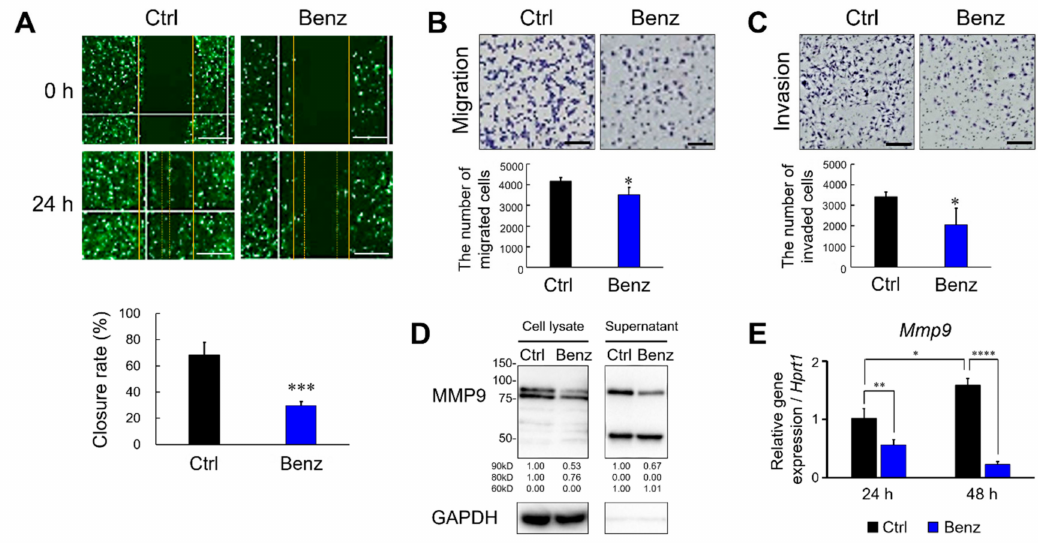
Figure 3. Suppressive actions of Benztropine on the migration and invasion of cancer cells. ( A ) Wound healing assay. The solid lines indicate the initial wounds. The dotted lines indicate the leading edge of the closing wound. Upper panel, representative images. Lower panel, rate of the wound closure. Mean ± SD, n = 4. *** P < 0.001 vs Ctrl. ( B , C ) Migration and invasion assays using a transwell system. LuM1 cells were treated with Benz (50 µ M) for 24 h. The ( B ) migrated and ( C ) invaded cells were stained with Di ff -Quick and then counted. Upper panels, ( B ) representative images of the migrated cells and ( C ) invaded cells. Scale bars, 100 µ m. Lower panels, the number of cells migrated or invaded in a well. Mean ± SD, n = 3. * P < 0.05 vs Ctrl. ( D ) Western blot showing MMP9 altered by Benz treatment. LuM1 cells were treated with Benz at 50 µ M for 24 h. Whole cell lysate and culture supernatant were prepared from the cells cultured in a serum-free medium for 24 h. Bands of approximately 90 kD (pro-form), 80 kD (active-form), and 60 kD (short-form) of MMP9 were detected. GAPDH, loading control. Densitometric readings for all western blots were calculated relative to the Ctrl. ( E ) RT-qPCR analysis for MMP9 mRNA levels. LuM1 cells were treated with 20 µ M Benz for 24 h and 48 h under 3D culture condition. Mean ± SD, n = 3. * P < 0.05, ** P < 0.01, and **** P < 0.0001 vs Ctrl. The mRNA levels were normalized with an internal control Hprt1